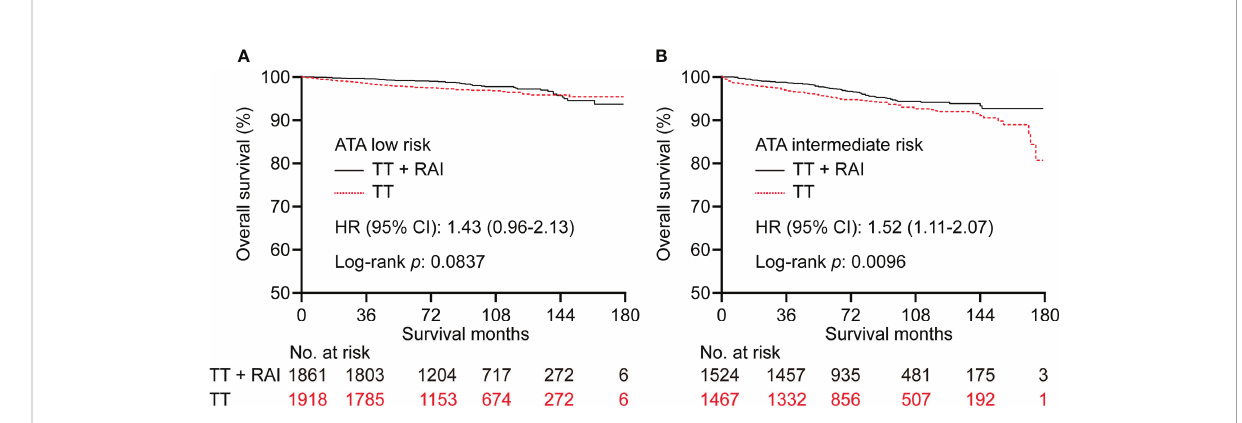
FIGURE 5 Kaplan – Meier curves of OS in PTC patients underwent TT vs. TT+RAI after PSM in low-risk (A) and intermediate-risk (B) patients strati fi ed by the ATA risk strati fi cation. OS, overall survival; PTC, papillary thyroid carcinoma; TT, total thyroidectomy; RAI, radioactive iodine; PSM, propensity score matching; ATA, American Thyroid